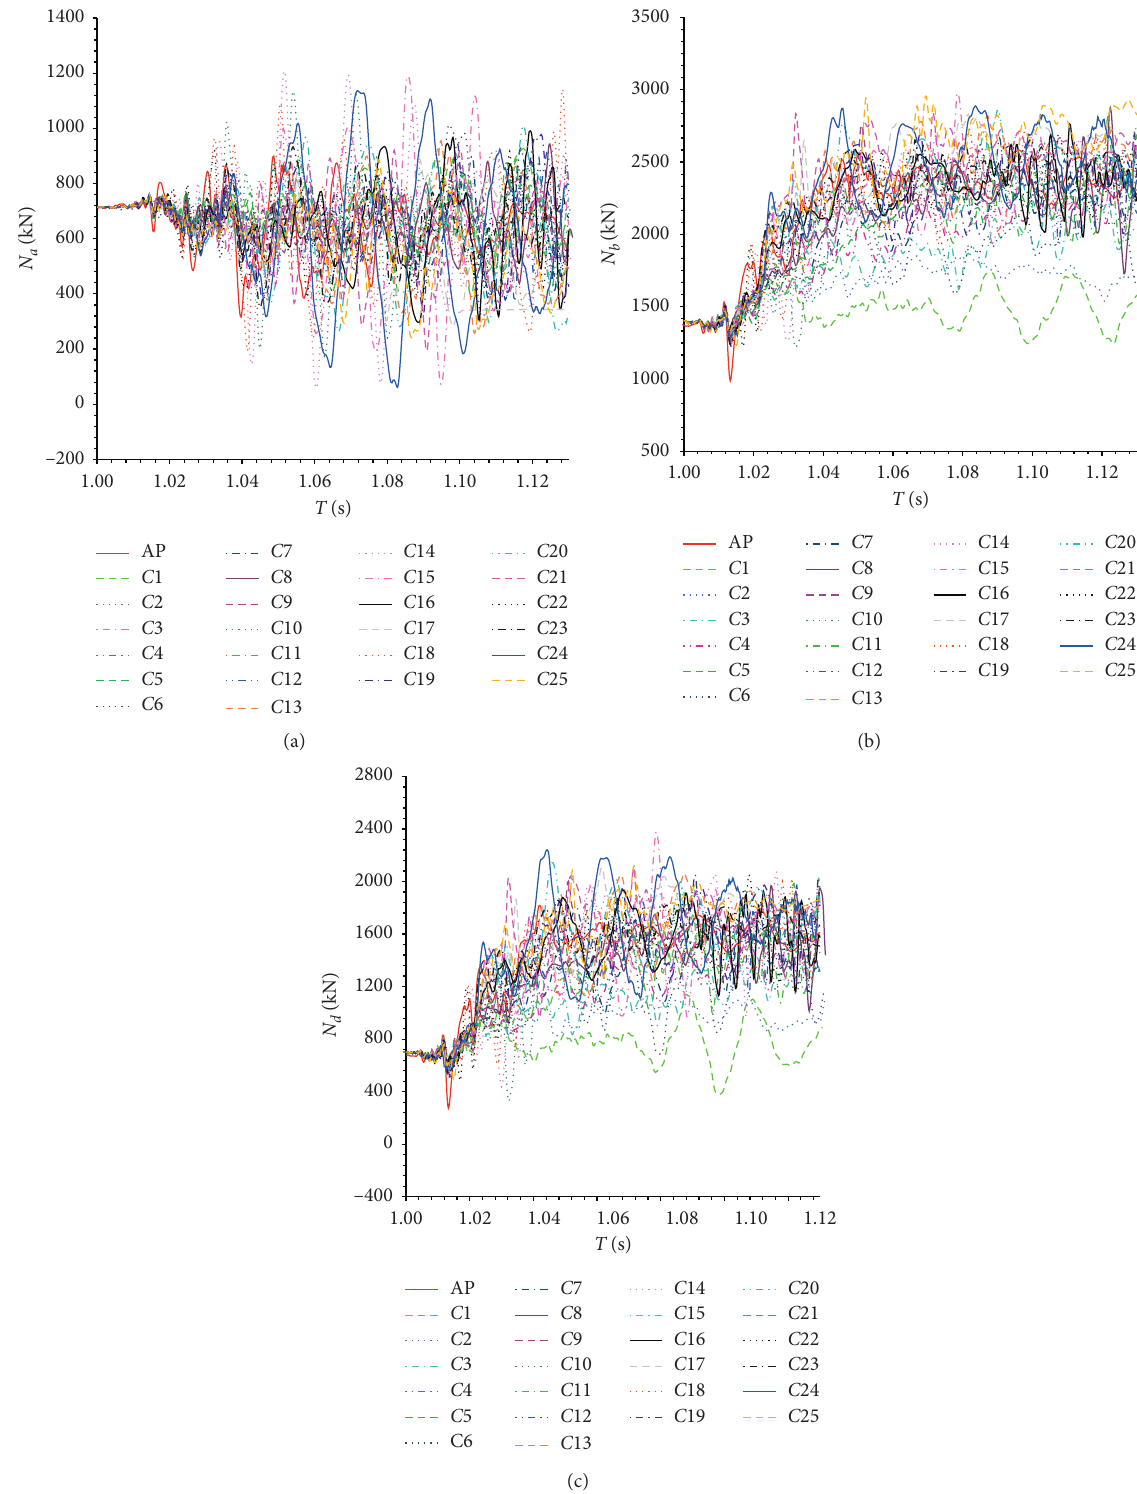
Figure 10: Internal force versus time ( T ) curves. (a) Axial force of the A bottom column. (b) Axial force of the B bottom column. (c) Axial force of the D bottom